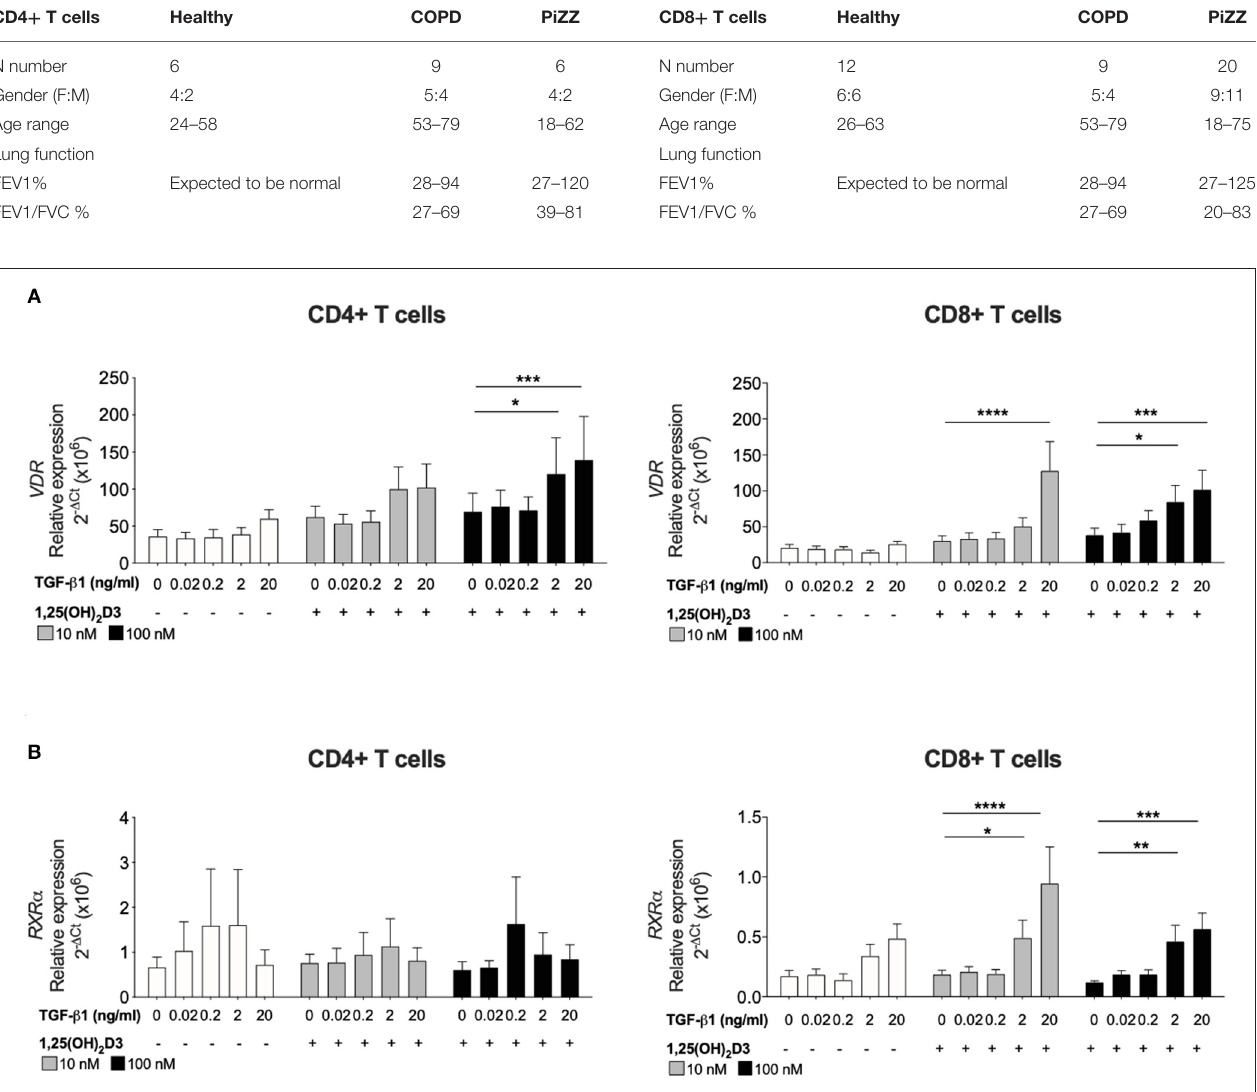
FIGURE 1 | TGF- β 1 together with 1,25(OH) 2 D3 upregulates VDR and RXR α gene expression by CD8 + T cells. CD4 + and CD8 + T cells ( n = 6) were stimulated and cultured for 7 days in the absence or presence of 10 or 100nM 1,25(OH) 2 D3, with or without TGF- β 1 (0.02, 0.2, 2, 20ng/ml). Gene expression of (A) VDR and